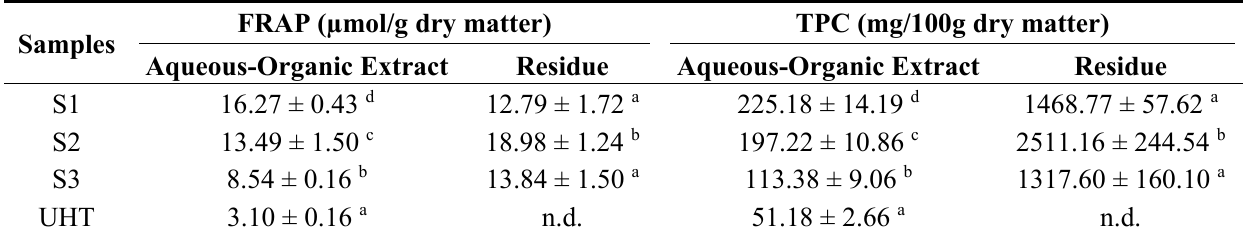
Table 1. FRAP and TPC values of soy-based beverages and UHT cow